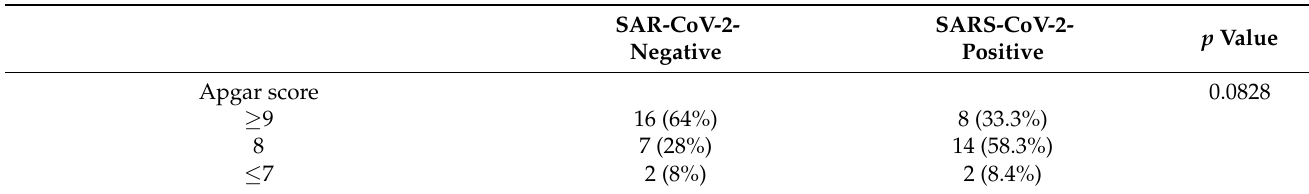
Table 2. Characteristics of the newborns. Anthropometric characteristics of newborns are expressed as mean (± SD).